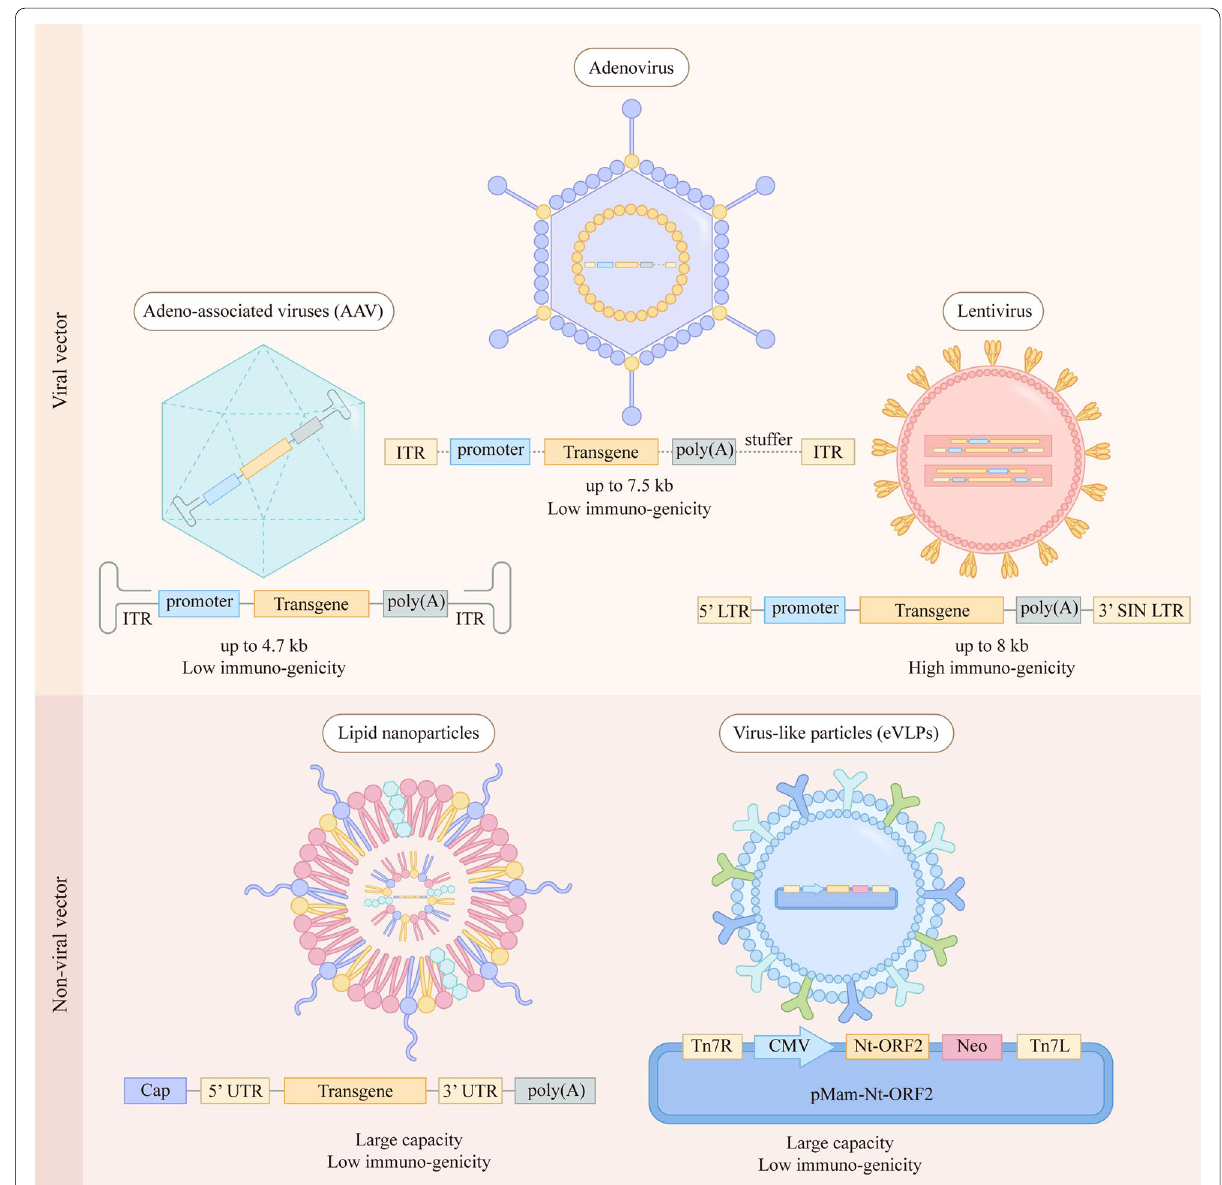
Fig. 2 Schematic diagram of viral vectors and non-viral vectors. Schematic of lentivirus and genetic components of lentiviral vectors. Two copies of positive-strand RNA are surrounded by the protein capsid and envelope; the therapeutic transgene is inserted between the two LTRs. Schematic of adenovirus and genetic components of adenoviral vectors. Double strand genome DNA is surrounded by the protein capsid and envelope; the adenoviral vector is stripped of all viral coding sequences, resulting in a vector with only 5’ and 3’ ITRs in addition to a packaging signal. Schematic of AAV and genetic components of rAAV vectors. A single-stranded genome is surrounded by the protein capsid; the therapeutic transgene, along with associated promoter and polyadenylation sequences, is inserted between the two ITRs. Schematic of lipid nanoparticles and genetic components of lipid nanoparticles vectors. The untranslated regions (UTRs) flank both the 5’ and 3’ ORFs, and genes encoding structural proteins are replaced by genes coding for proteins of therapeutic value. Schematic of eVLPs and genetic components of Hepatitis E virus (HEV)-like particles (HEV-LPs) vectors. Hepatitis E virus (HEV) is a liver selective tropism virus in which the major capsid protein of HEV is encoded by its second open reading frame (ORF2) and can be easily assembled to form VLPs17. The ORF2 protein with a deletion of 111 amino acids from the N-terminal end composes the N-terminally-truncated ORF2 (Nt-ORF2), and can form smooth self-assembled HEV-like particles